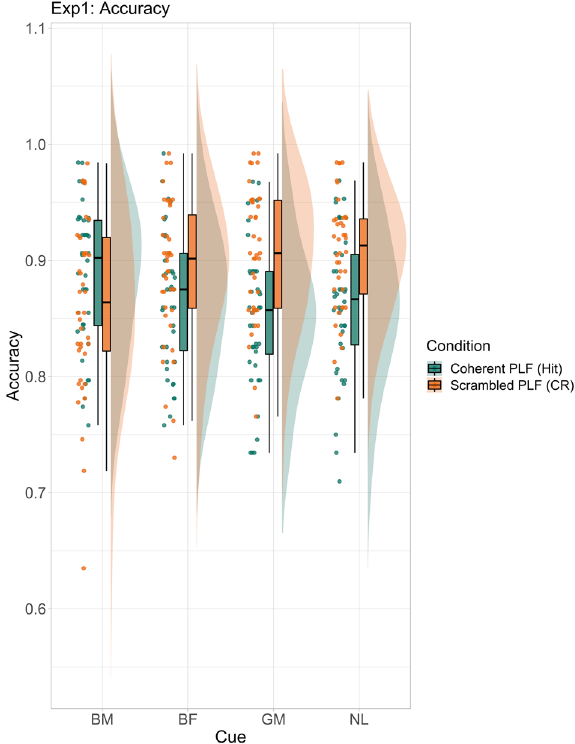
Figure 2. Accuracy (raw data) for coherent (hit) and scrambled (correct rejection; CR) PLF conditions for Experiment 1. Cue names are as follows: BM biological motion, BF biological form, GM general motion, NL no